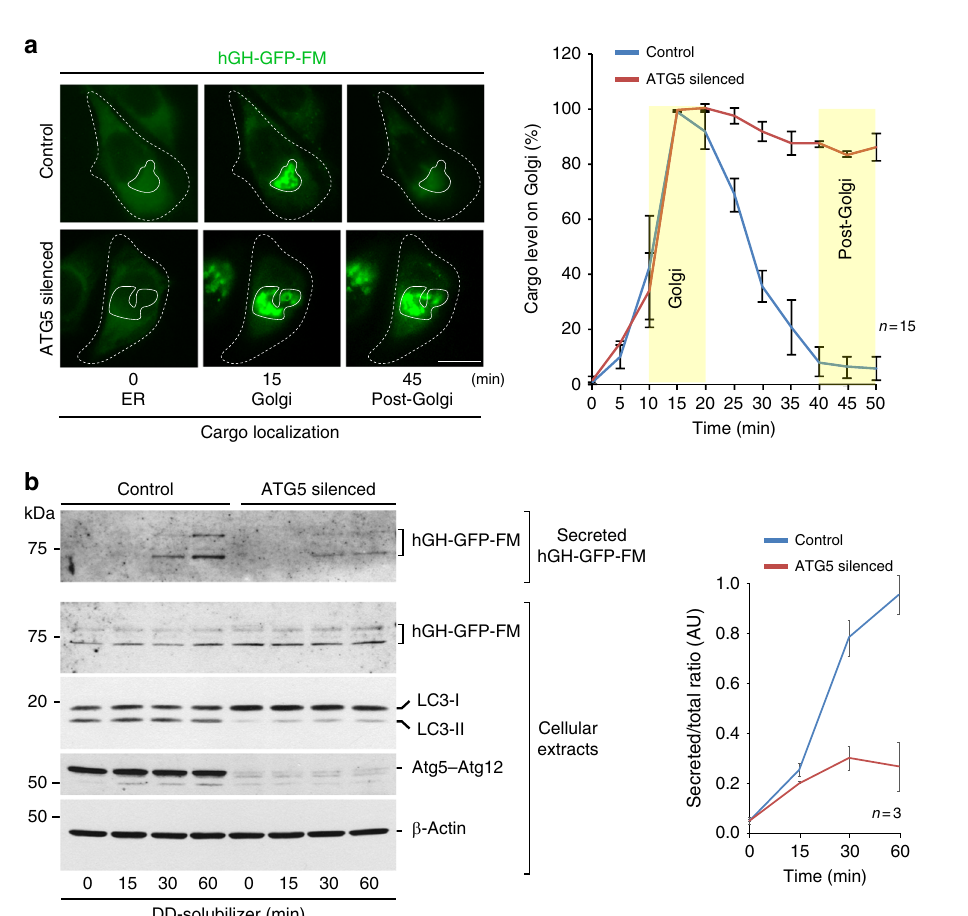
Fig. 5 The fusion of autophagosomes and lysosomes is regulated by KDELR and DynLRB1. a H4 cells transfected to express the pH-sensitive autophagy fl ux marker LC3 (mcherry-GFP-LC3) were left untreated (Control) or incubated for 15 or 30 min at 37 °C with 1 µ M KDEL-BODIPY peptide alone, or in combination with 10 µ M R8-Gs peptide. The graph depicts the quanti fi cation of cells with autophagosomes that were regarded as puncta showing mcherry and green fl uorescent protein (GFP) fl uorescence ( n = 50 cells). b H4 cells transfected as in a were subjected to nutrient starvation for 1 h to induce autophagosome formation, and then incubated with cell-permeable peptides as in a . The graph depicts quanti fi cation of cells ( n = 50 cells) with autophagosomes as indicated in a . c Quanti fi cation of the ratio between autolysosomes and autophagosomes in cells treated as indicated in b . Autolysosome/autophagosome ratio was calculated by automatic counting of red (mcherry, pH-insensitive) and green (GFP, pH-sensitive) positive puncta ( n = 50 cells). d – h HeLa cells were co-transfected to express mcherry-GFP-LC3 and either of the indicated DynLRB1-HA (hemagglutinin) variants, and either left untreated ( d , g and h ) or incubated for 30 min with 1 µ M KDEL-BODIPY ( e and f ). Insets show linescans (25-length × 4-width pixels) of representative regions depicting the presence of red and green fl uorescent emission pro fi les of autophagic puncta. Red and green emission identi fi es puncta as autophagosomes, and lack of green emission identi fi es puncta as autolysosomes ( n = 3 independent experiments). Scale bars, 10 µ m. i Quanti fi cation of the ratio between autolysosomes and autophagosomes as indicated in c in cells ( n = 50 cells) treated as indicated in d – h . Data are means ± SEM. * p < 0.05; *** p < 0.001 (Student ’ s t tests). All t tests were conducted comparing to control